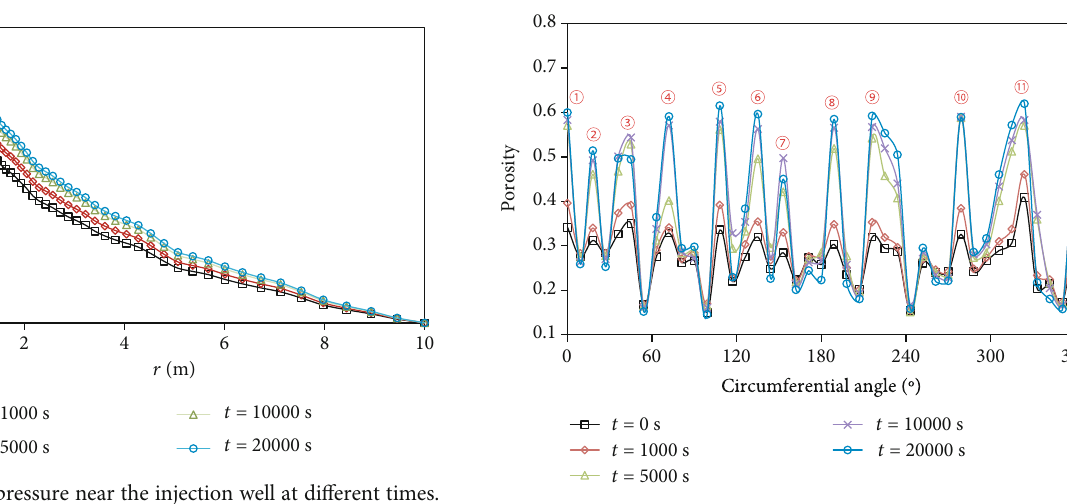
Figure 5: Porosity distribution pro fi les surrounding the injection well at r = 0 : 4m